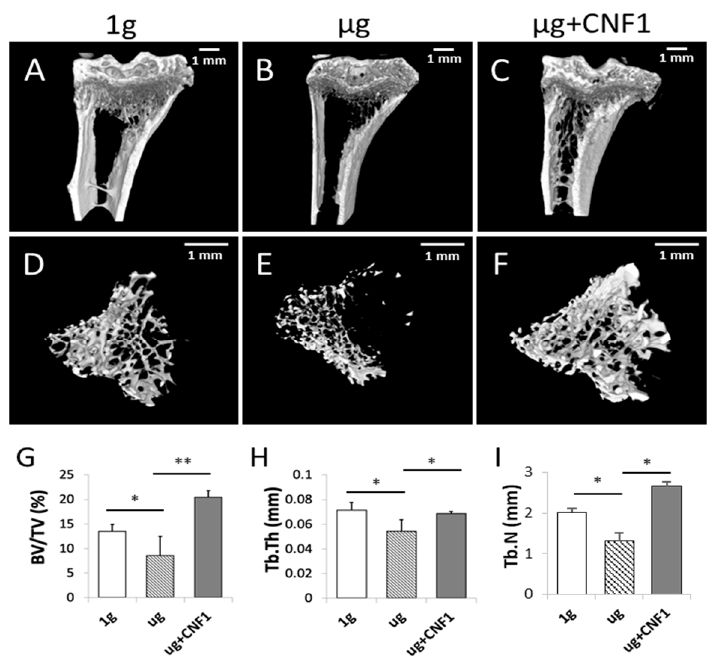
Figure 4. Measurement of mouse proximal trabecular structures by micro-CT imaging in HU-treated ( n = 5), HU + CNF1-treated ( n = 4) and control ( n = 8) mice. ( A – F ) Micro-CT showed that HU-treated mice had significantly less trabecular bone formation than the control mice and that HU+CNF1-treated mice effectively converted HU-inhibited trabecular bone formation. ( G – I ) Bone volume fraction (BV/TV), trabecular thickness (Tb.Th) and trabecular number (Tb.N) all significantly decreased in tibias of HU-treated mice compared to control mice, and activation of FAK restored HU-affected trabecular bone formation. Scale bar: 1 mm. Data represent the mean ± SD. * p < 0.05 and ** p < 0.01 versus different groups by Student t test.